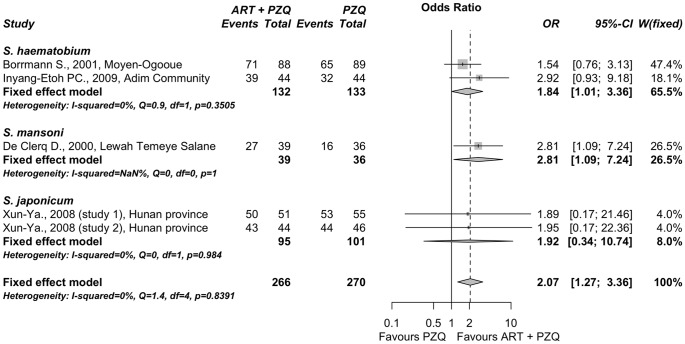
Forest plot of fixed-effect subgroup meta-analysis comparing parasitological cure after treatment with an artemisinin derivative plus praziquantel vs. praziquantel.Points represent odds ratios with their corresponding 95% C.I. Intermediate diamonds are combined odds ratios for each subgroup and the diamond at the bottom is the overall combined odds ratio. The vertical line emphasizes an odds ratio = 1 (no difference) and the dashed vertical line shows the value of the overall combined odds ratio. The original reports are labeled with author name, year and location (for details see table 2).